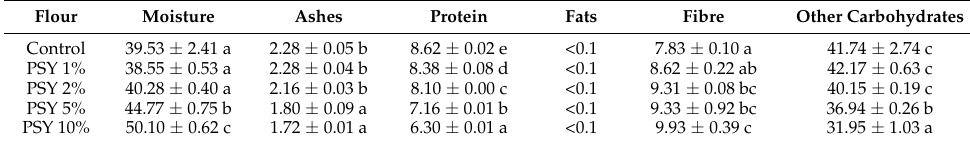
Table 3. Proximate composition of control and psyllium added whole